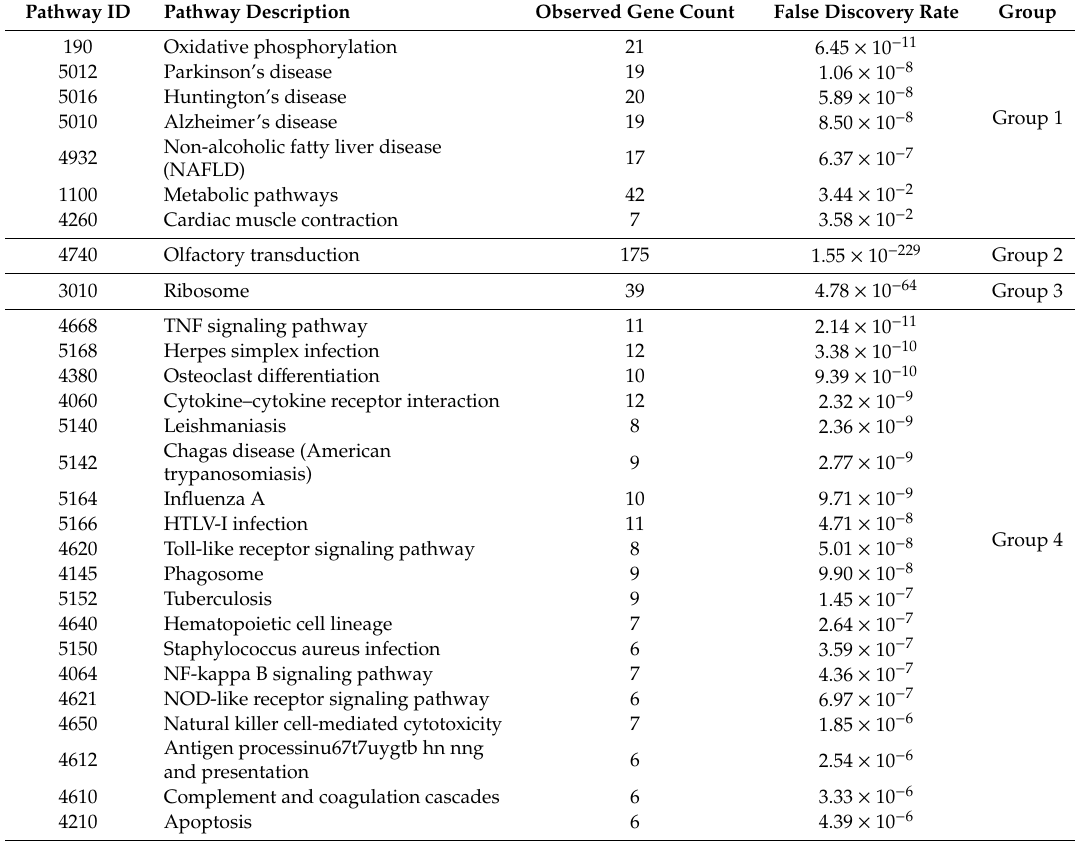
Table 1. Kyoto Encyclopedia of Genes and Genomes (KEGG) pathway analysis for the di ff erentially regulated gene during VSV infection.